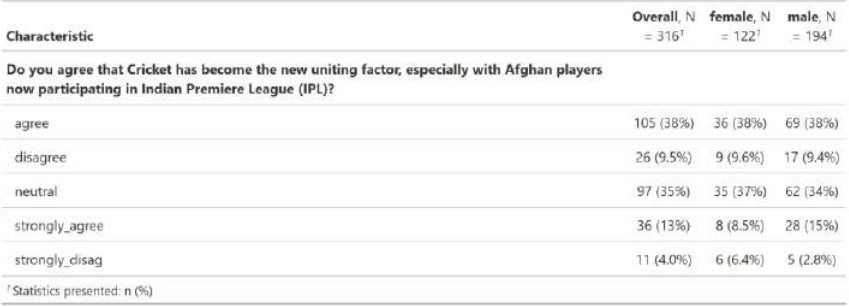
Table 26: Do you agree that cricket has become the new uniting factor, especially with Afghan players participating in the Indian Premier League (IPL)? ( Source: Authors‟ depiction )